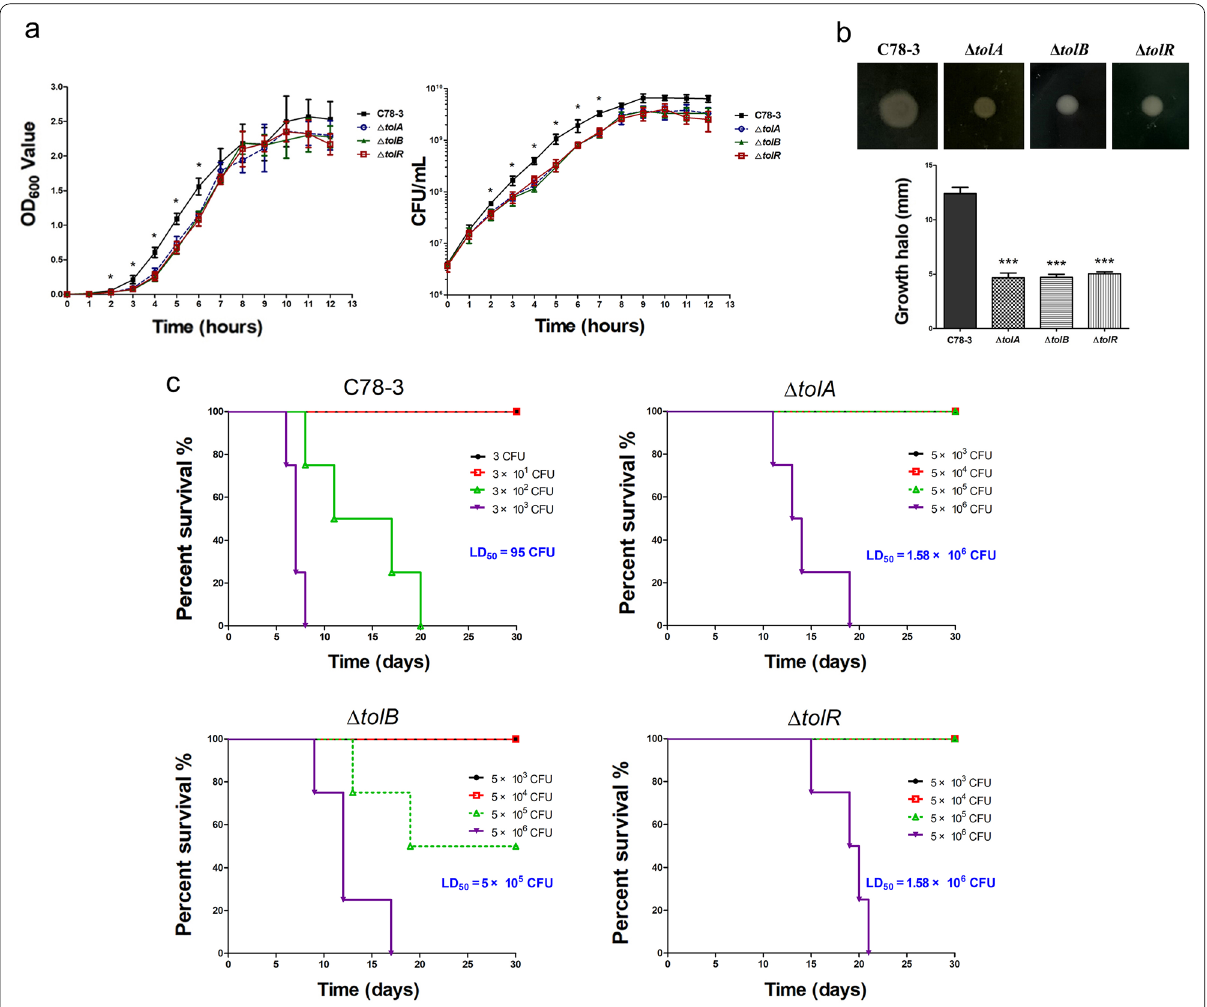
Fig. 4 The roles of tolA , tolB , and tolR in cell growth, motility, and virulence of S. Choleraesuis. a Growth curves of C78-3, Δ tolA , Δ tolB , and Δ tolR using OD 600 measurements, and the bacterial suspensions were serially diluted and plated to determine CFU numbers per milliliter. b Motility was evaluated by measuring the growth halo of C78-3, Δ tolA , Δ tolB , and Δ tolR. Each assay was completed in 3 independently conducted biology duplicates. * P < 0.05; ** P < 0.01; *** P < 0.001. c LD 50 evaluation of C78-3, Δ tolA , Δ tolB , and Δ tolR with a murine model. The infected mice were supervised every day for 30